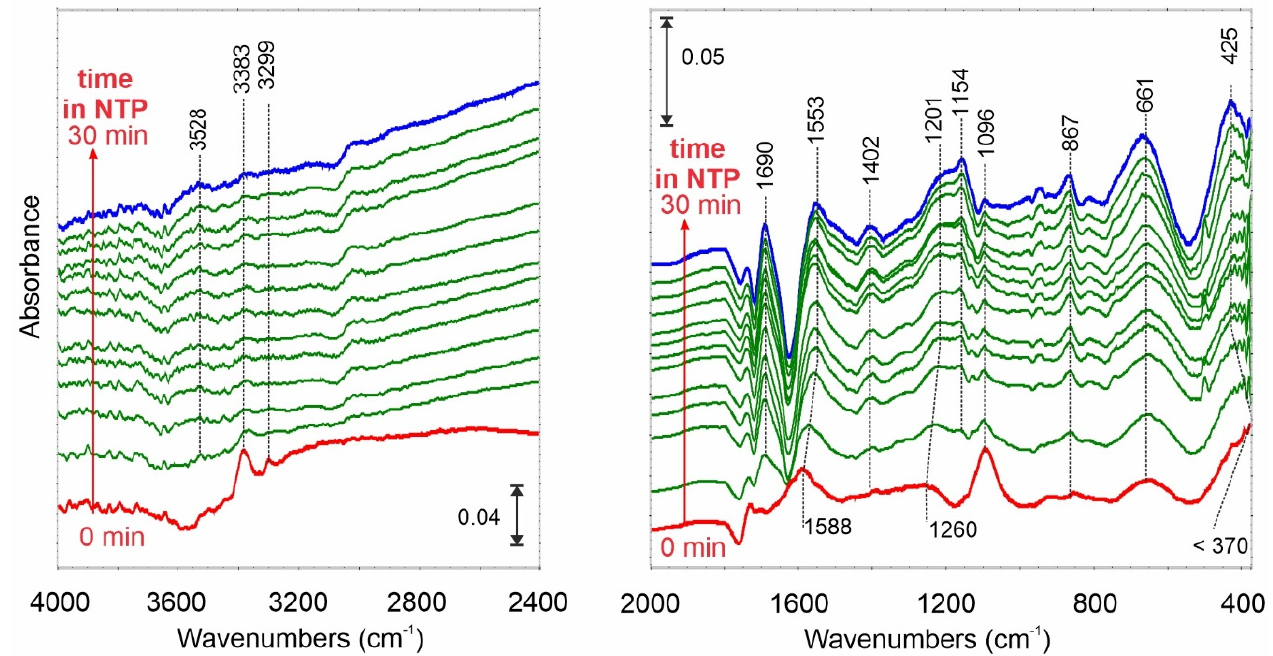
Figure 5. FTIR differential spectrum of C des carbon film after NH 3 adsorption at 25 °C (red spectrum—0 min) and time-resolved spectra when NTP is switched on from 0 to 30 min.